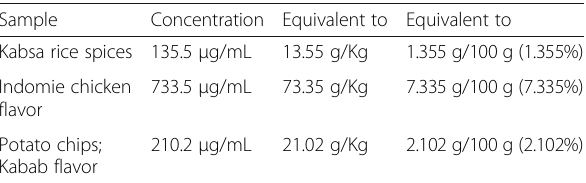
Table 4 The concentrations of Monosodium glutamate in food samples Sample